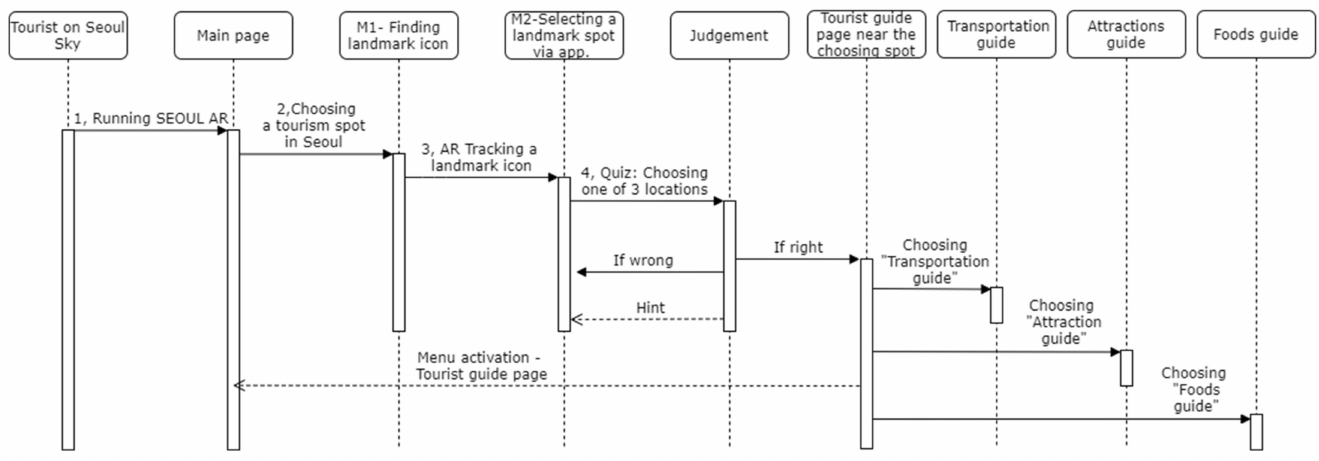
Figure 3. Seoul AR scenario